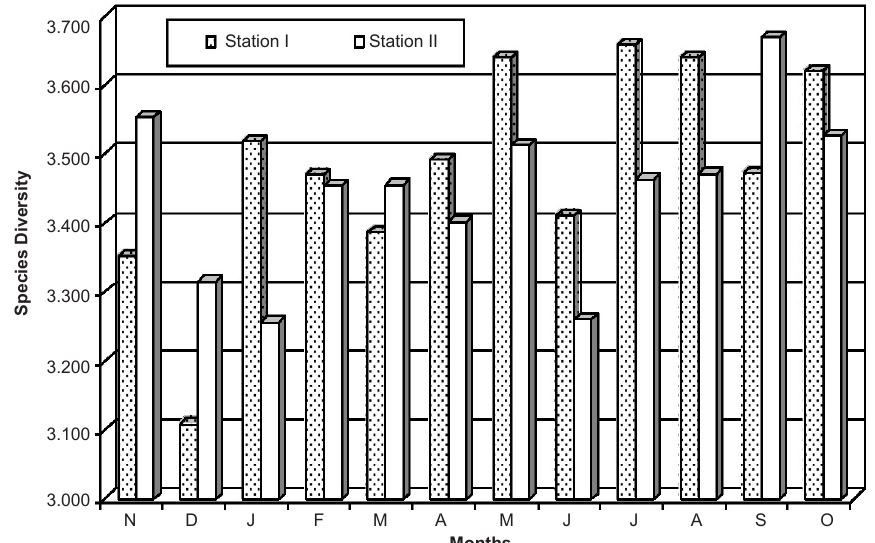
Figure 6. Monthly variations in species diversity of Rotifera